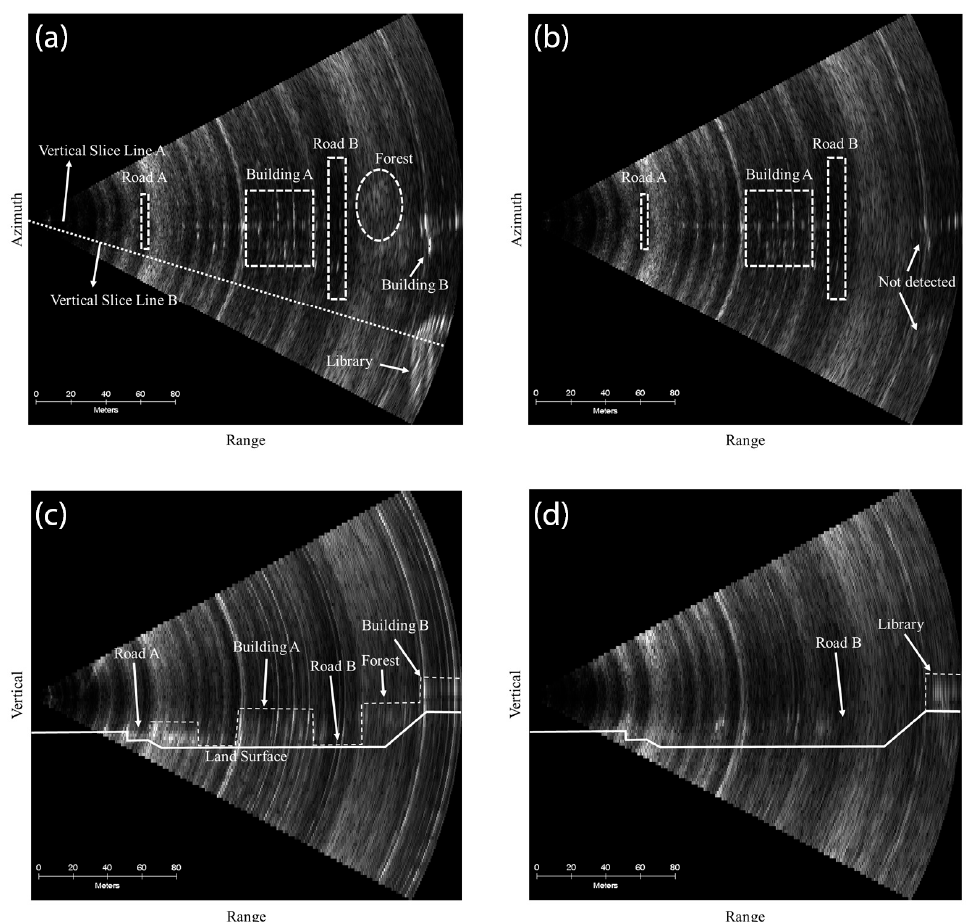
Figure 7. Slice images of GB-TomoSAR. ( a ) Range-azimuth slice image including the image center line, ( b ) range-azimuth slice on a plane vertically slanted by 7.84° downwards from the image center line, ( c ) range-vertical slice image including the image center line, ( d ) range-vertical slice intersecting the library building.